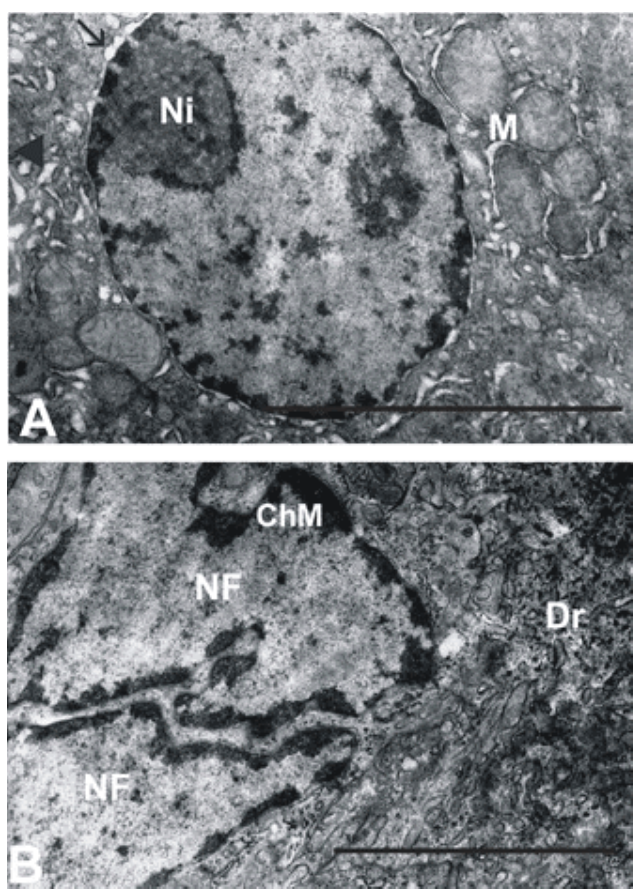
FIGURE 5. Ultrastructural changes of hepatocytes of young rats in the process of apoptosis. (A) Large nucleolus (Ni) and primary features of chromatin margination in nucleus with expanded perinuclear space (arrow); swollen cisterns of RER (arrowhead) surrounding mitochondria (M). Three hours after injection of cycloheximide. (B) Apoptotic hepatocyte the nucleus of which underwent karyorrhexis; nuclear fragments (NF) with marginated chromatin (ChM); cytoplasm contains hardly identified structures and debris (Dr) of incompletely dissolved organelles. Four hours after injection of antibiotic. (C) Fragment of nucleus of apoptotic hepatocyte with intensive chromatin margination; cytoplasm contains long, flattened, closed-at-times unidentified elements, possibly debris of mitochondria; solitary empty mitochondria (M). Four hours after injection. (D) Apoptotic body (AB) with great number of nuclear fragments is surrounded by phagocytic cell (PhC). Four hours after injection of cycloheximide. Scale bars 5 μ